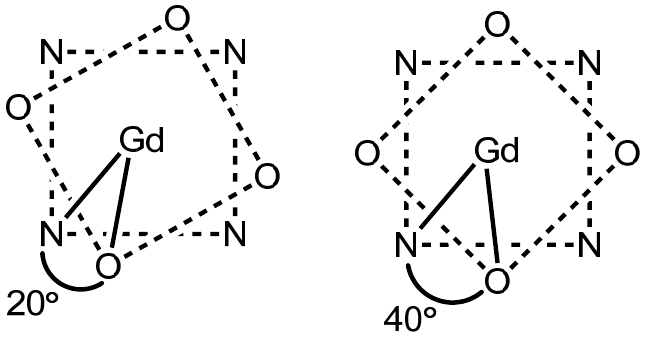
Figure 9. Top-down view of (left) TSAP and (right) SAP isomers with the O–Gd III –N twist angles indicated. In these views, the oxygen plane is above the Gd III ion and the nitrogen plane is below the Gd III